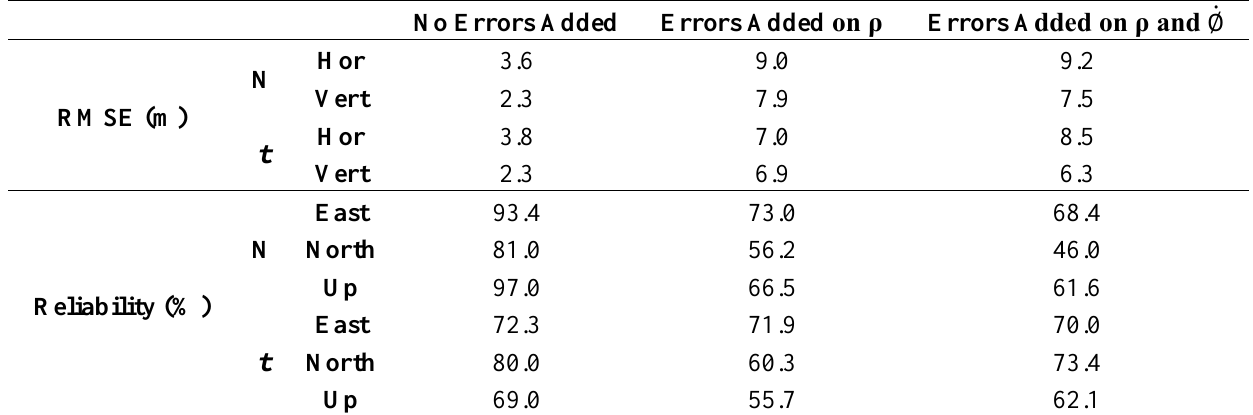
Table 2. RMSE and reliability for open sky data.